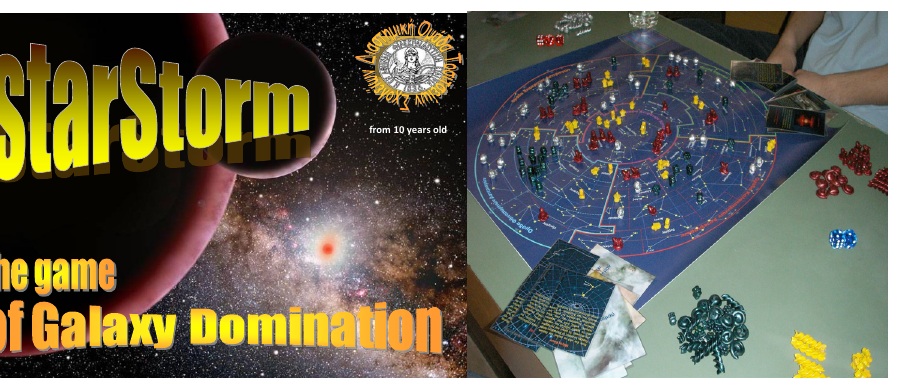
Fig.1 The board game